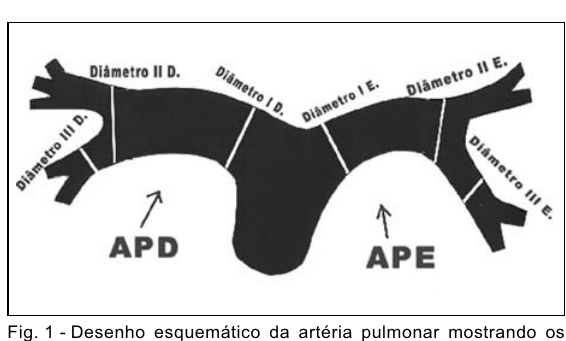
Fig. 1 - Desenho esquemático da artéria pulmonar mostrando os locais das medidas dos diâmetros I, II e III em ambos os lados. APD – artéria pulmonar direita; APE – artéria pulmonar